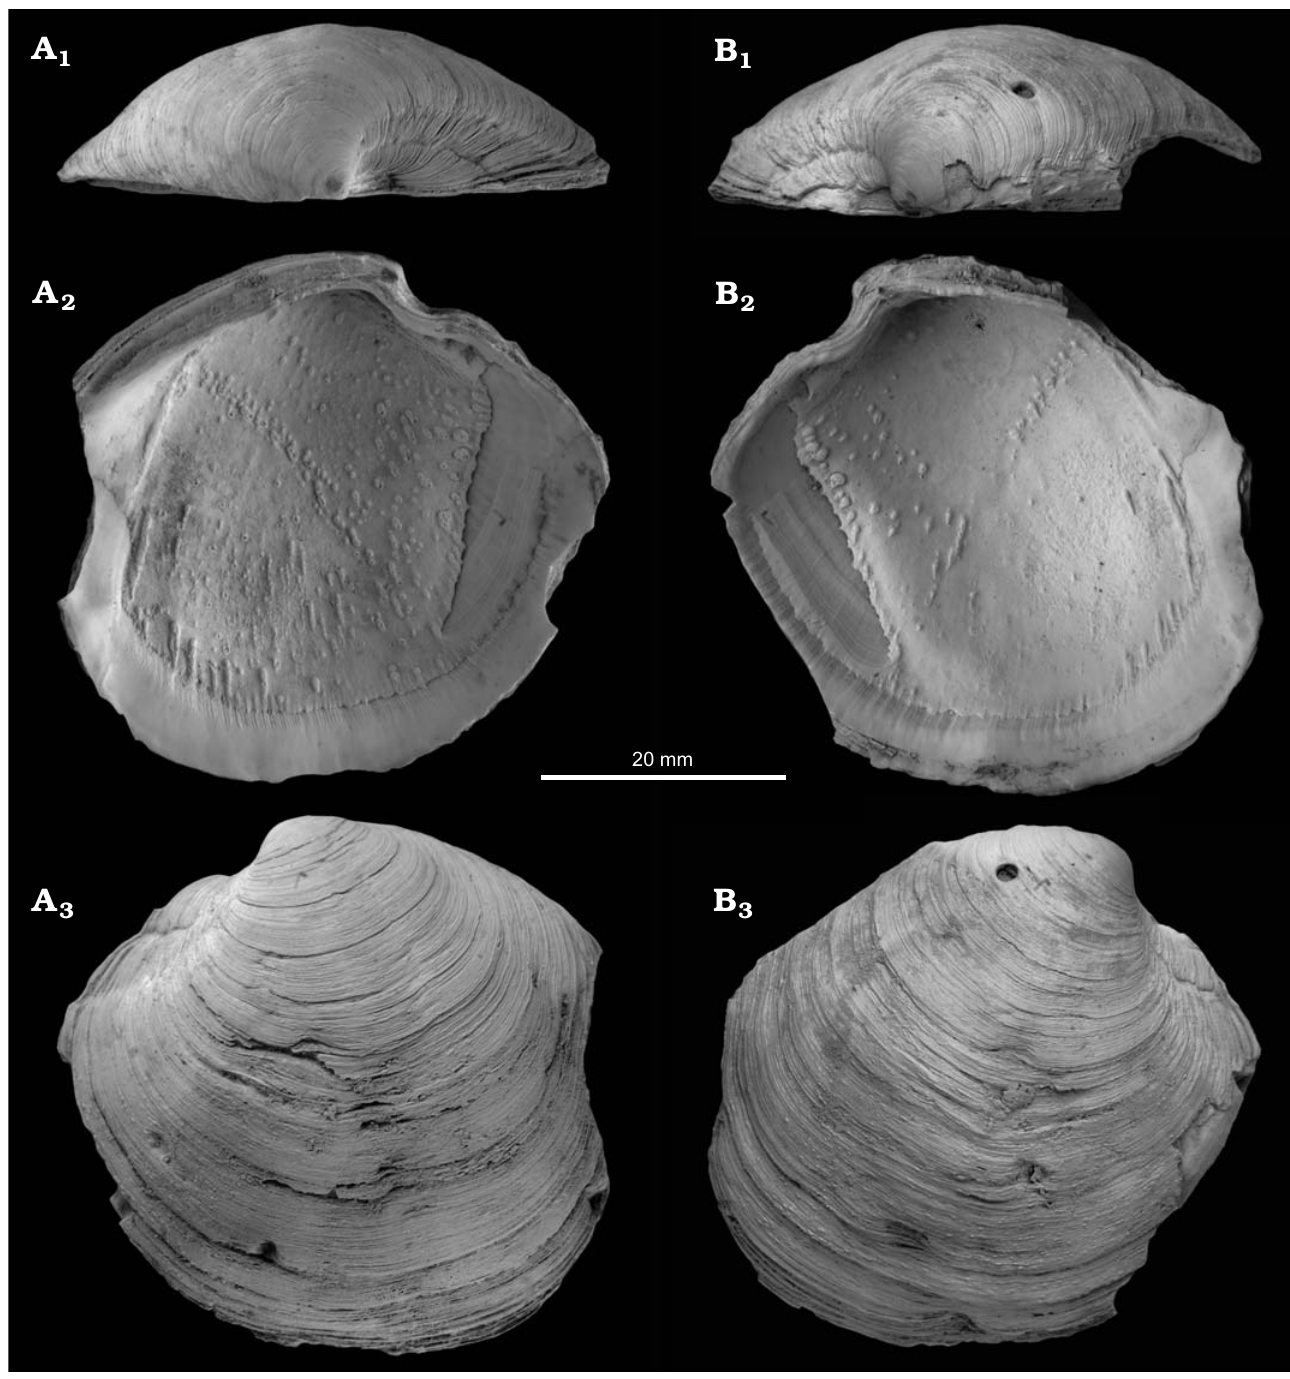
Fig. 4. The lucinid bivalve Megaxinus stironensis sp. nov. from the late Pliocene of Italy, Stirone River seep deposit. MGGC.22009, holotype, left ( A ) and right ( B ) valves in dorsal views (A 1 , B 1 ), views on the interior including hinge, muscle attachment scars and blood vessel attachment scar (A 2 , B 2 ), and views of exterior (A 3 , B 3